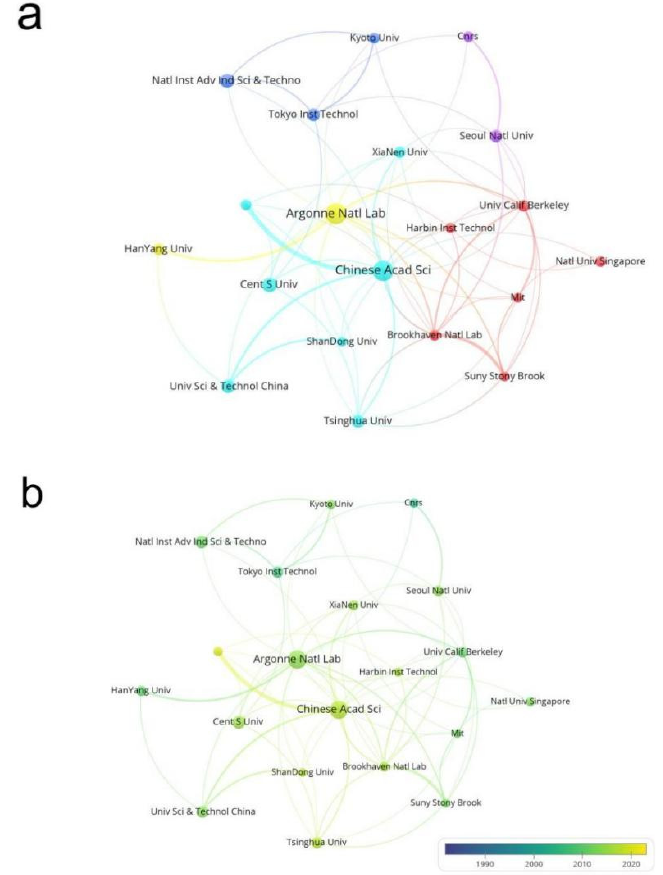
Table 3. Top 10 authors of articles on waste lithium-ion battery